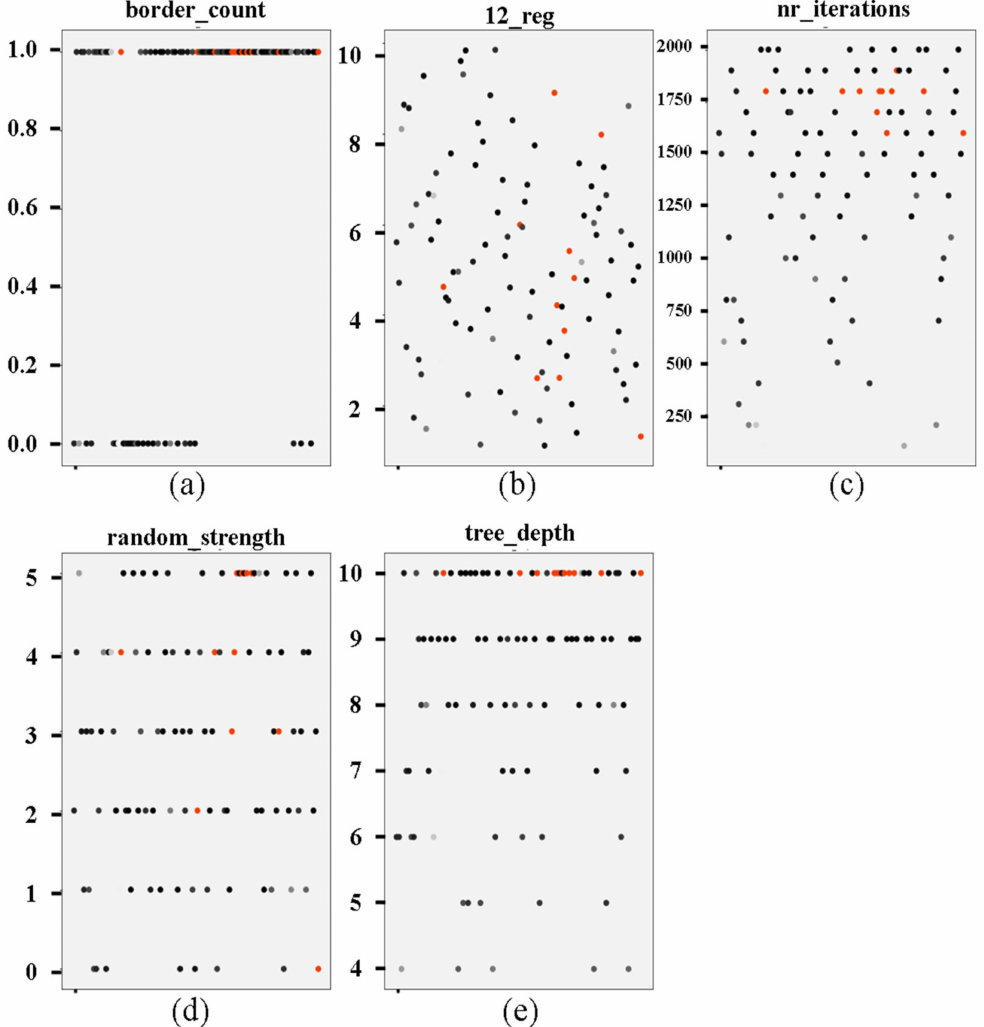
Figure 7. Scatter plot of best optimal model parameter with ( a ) ‘border_count’: 1, ( b ) ‘l2_reg’: 4.8139, ( c ) ‘nr_iterations’: 1900.0, ( d ) ‘random_strength’: 5.0, and ( e )’ tree_depth’: 10.0.